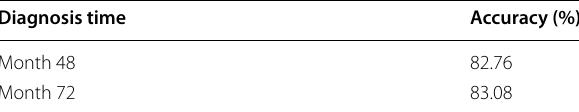
Table 8 Combined model’s overall diagnosis